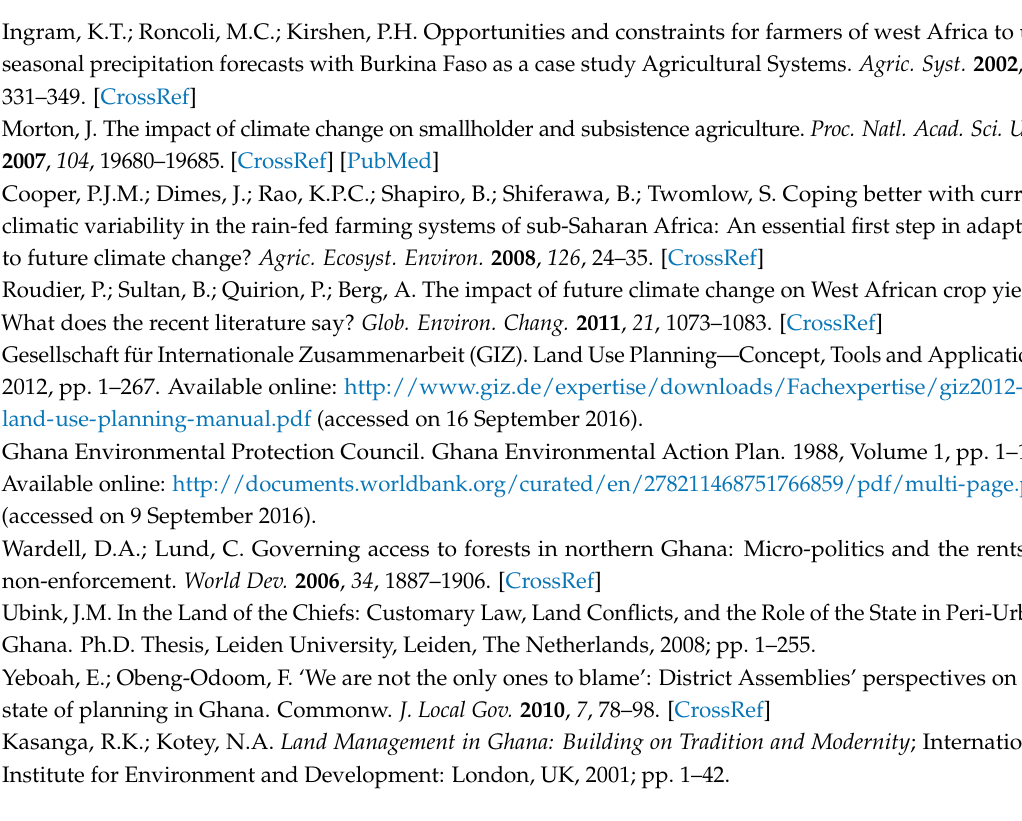
Table S1: Template of the stakeholder survey to select ecosystem services based on the importance related to agricultural land use, Table S2: Template of the stakeholder survey to identify the perceptibility of the differences on the provision of ecosystem services between land use types, Table S3: Template of the stakeholder survey for data generation, Table S4: Part of a stakeholder survey template for the identification of scenario impacts, Table S5: Application conditions of land use scenarios, Table S6: Impact of land use scenarios on the ecosystem services provision based on a stakeholder survey. Each percentage implies the extent of potential increase or decrease from the supply capacity of the current land use types when a scenario is